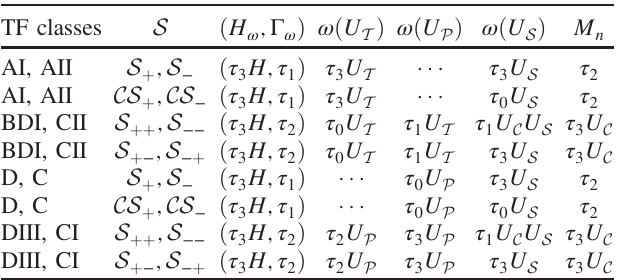
TABLE XV. The action (36) of the order-raising homomor- phism ω on a Hamiltonian in the real tenfold-way classes with a unitary order-two symmetry or antisymmetry. M line-symmetry-breaking mass term generated by the homomor- phism ω .